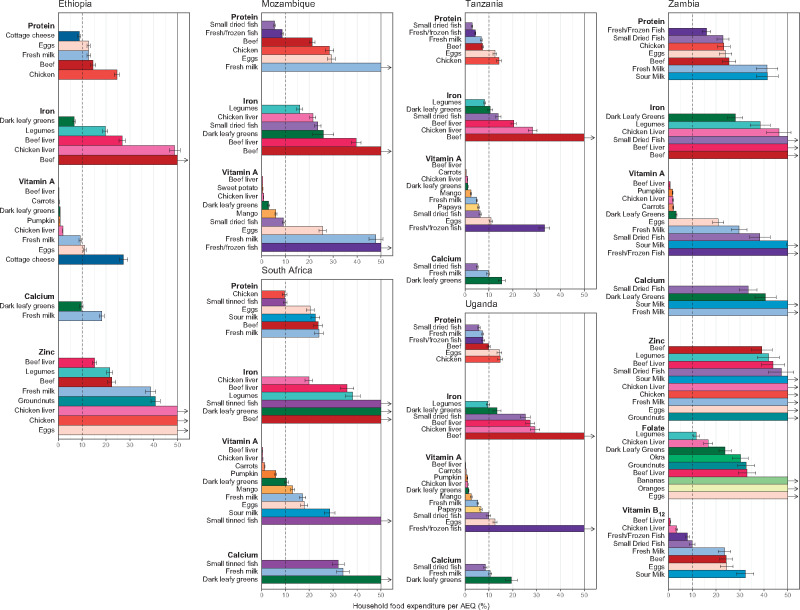

Portion-size cost as a share of total household food expenditure per adult equivalent. The y-axis was truncated at 50%, but the costs of some foods exceeded 50% of household food expenditure per adult equivalent (AEQ); these foods are designated with vertical arrows indicating that the bar continues vertically beyond the scale of the graph. Regional price data were not available for Zambia and thus the CIs shown on the Zambia panel do not incorporate geographic price variation. Only households with children of complementary feeding age are shown, yielding sample sizes of 5808 households in Ethiopia, 9441 in Mozambique, 3303 in South Africa, 1062 in Tanzania, 728 in Uganda, and 2054 in Zambia. Error bars represent 95%CIs